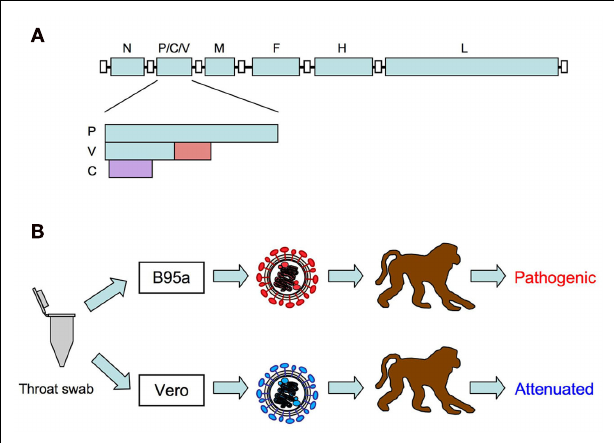
FIGURE 1 | (A) Schematic diagram of measles virus genome.The P gene encodes the P protein and the non-structuralV and C proteins.TheV protein is translated from an edited RNA with a non-templated G residue.TheV protein-specific region is indicated in red.The C protein is translated from an alternative open reading frame (purple) initiated by the second AUG. (B) Isolation of wild-type MV using B95a cells. Pathogenic wild-type MV strains can be isolated by inoculating throat swabs from measles patients in B95a cells. MV strains isolated inVero cells lose their